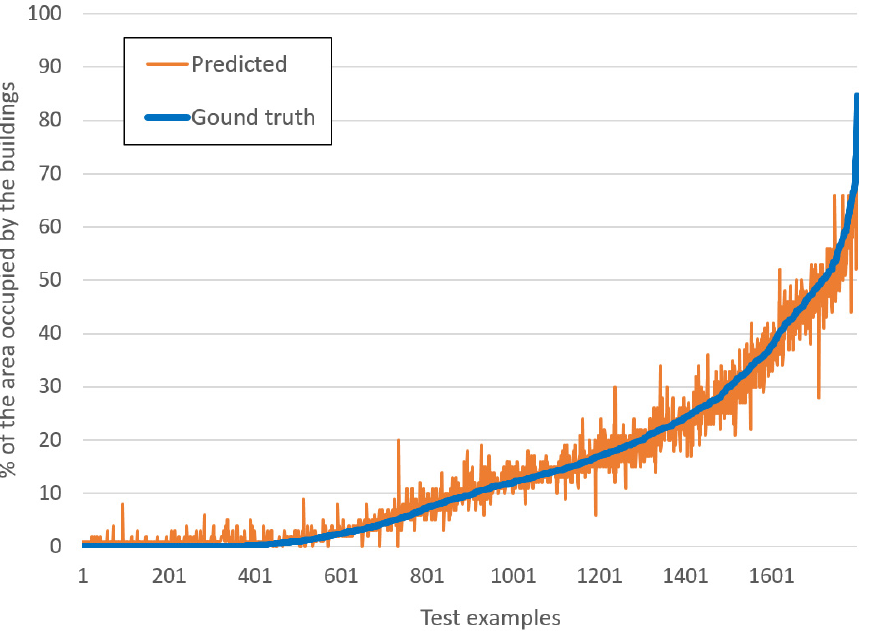
Figure 11. Scatter plot of predicted values versus ground truth, for the aerial image labeling dataset, Xception * 3 model.